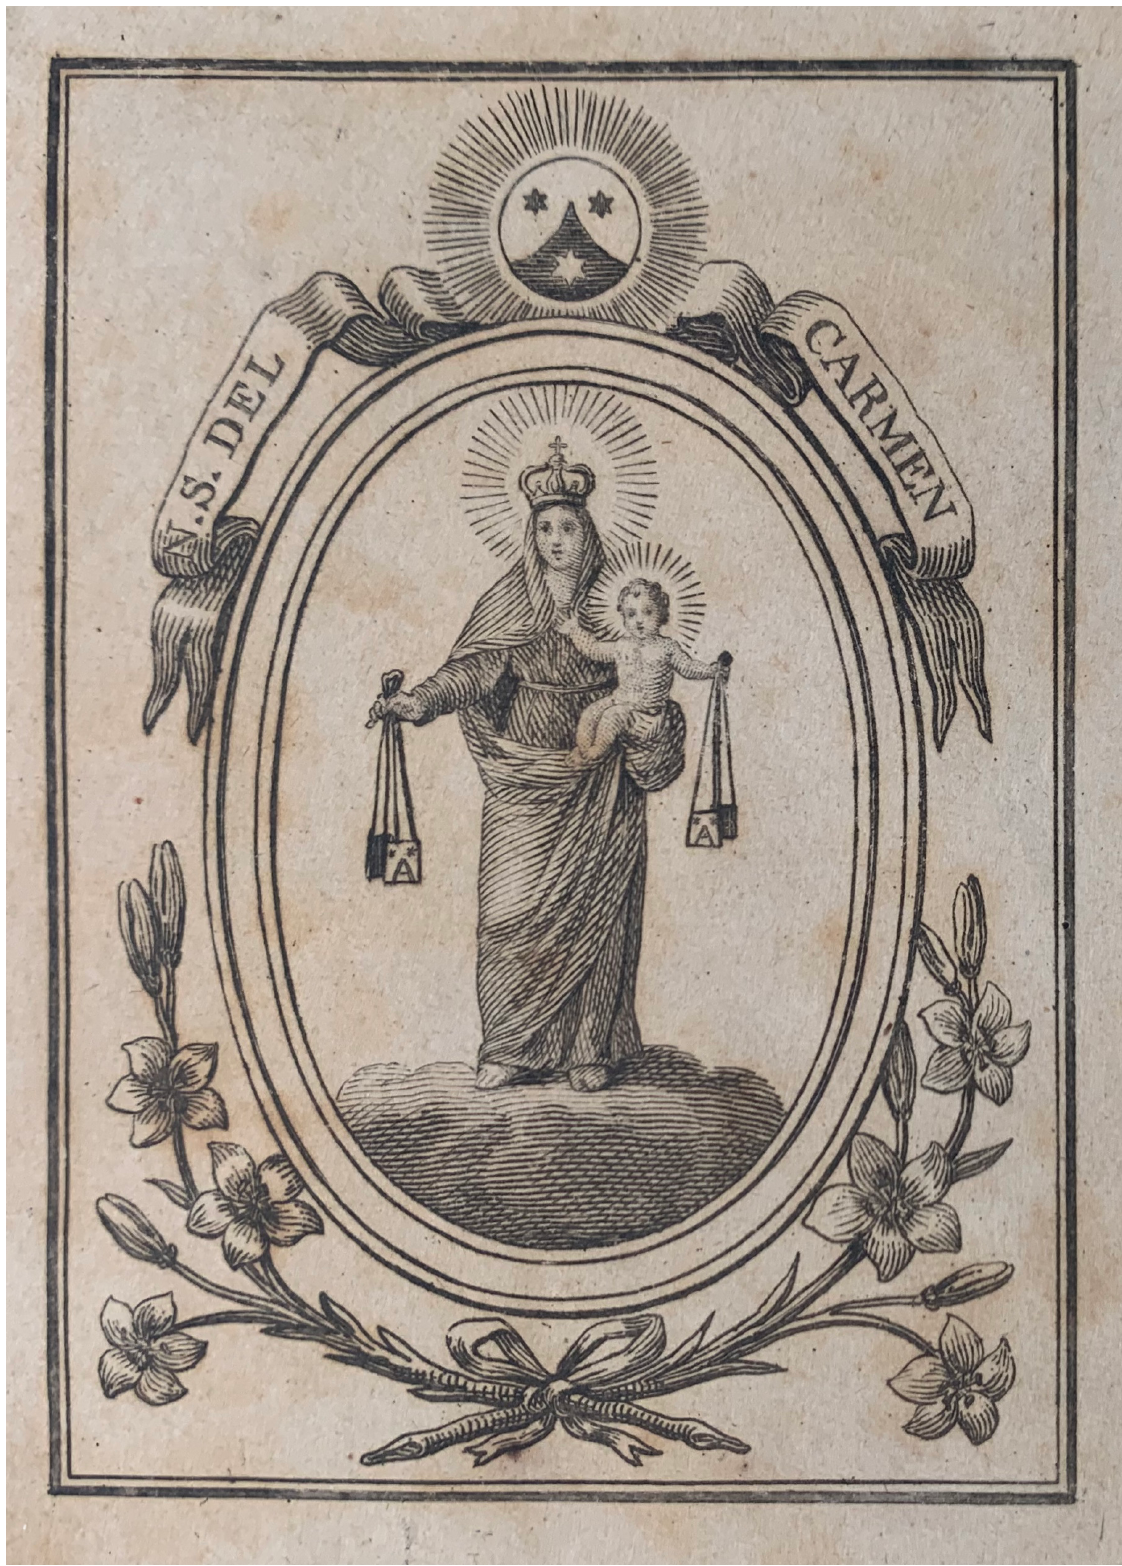
Figure 3 Our Lady of Carmel , nineteenth century holy card, engraving, Italy. Collection of the